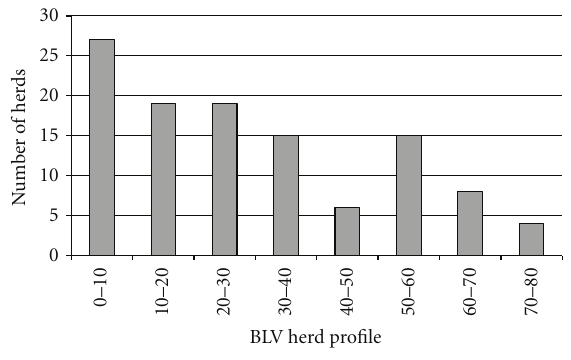
Figure 1: Frequency distribution of Bovine Leukemia Virus herd profile (BHP) for 113 dairy herds in Michigan. For each herd, the percent of cows that tested Bovine Leukemia Virus (BLV) positive within the first, second, third, and fourth or greater lactations (ten cows from each lactation) was averaged to calculate the BHP. The 25th, 50th, and 75th percentiles were 14.6, 30.0, and 48.9, respectively.